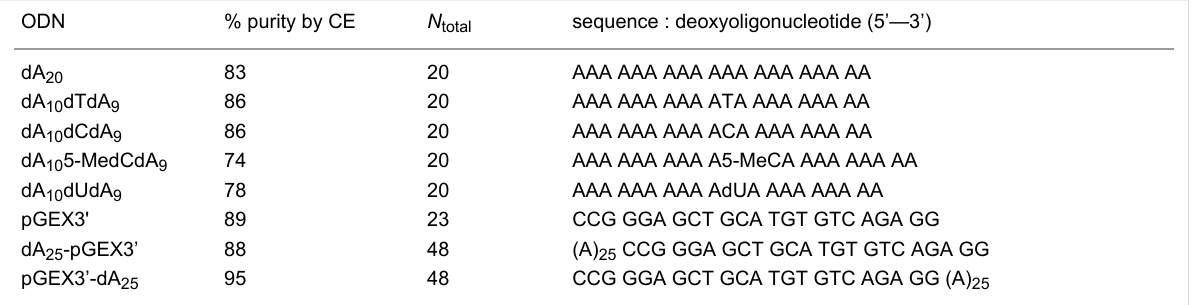
Table 1: List of oligos used in this study, their purity (see Experimental), total number of nucleotides, N total , and sequence. The data obtained can be found in Table 2. ODN % purity by CE N total sequence : deoxyoligonucleotide